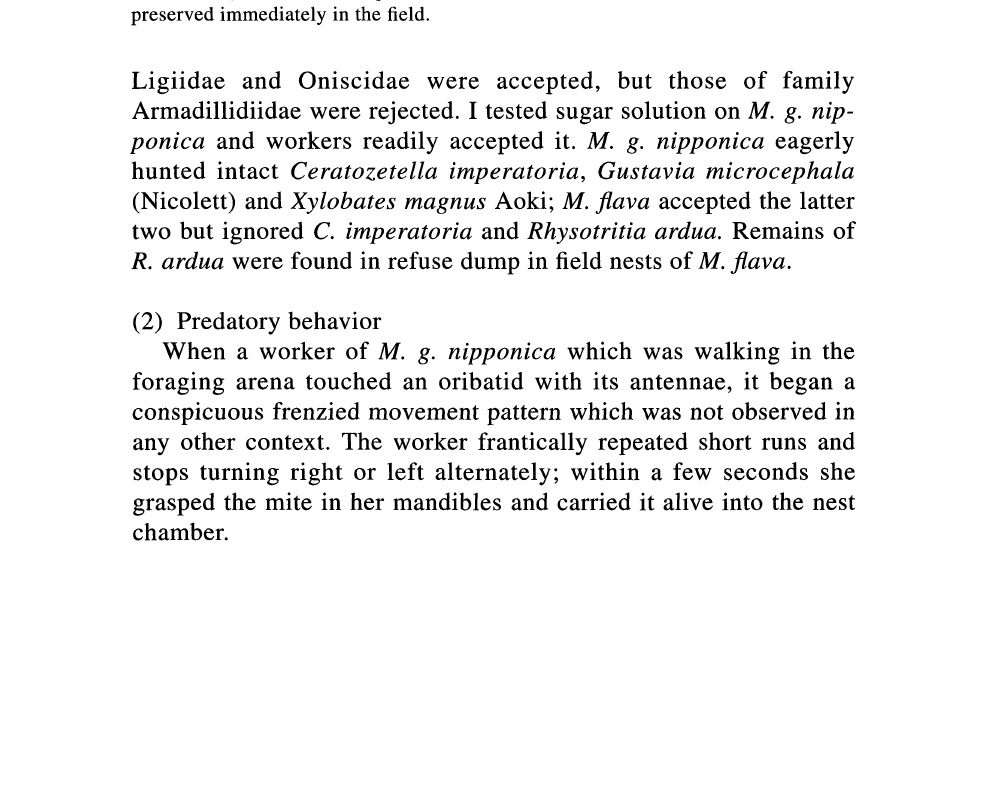
Fig. 2. Larvae of M. g. nipponica, one of which is inserting its head into an ori- batid mite (Ceratozetella imperatoria). Both larvae are of the final instar and were preserved immediately in the